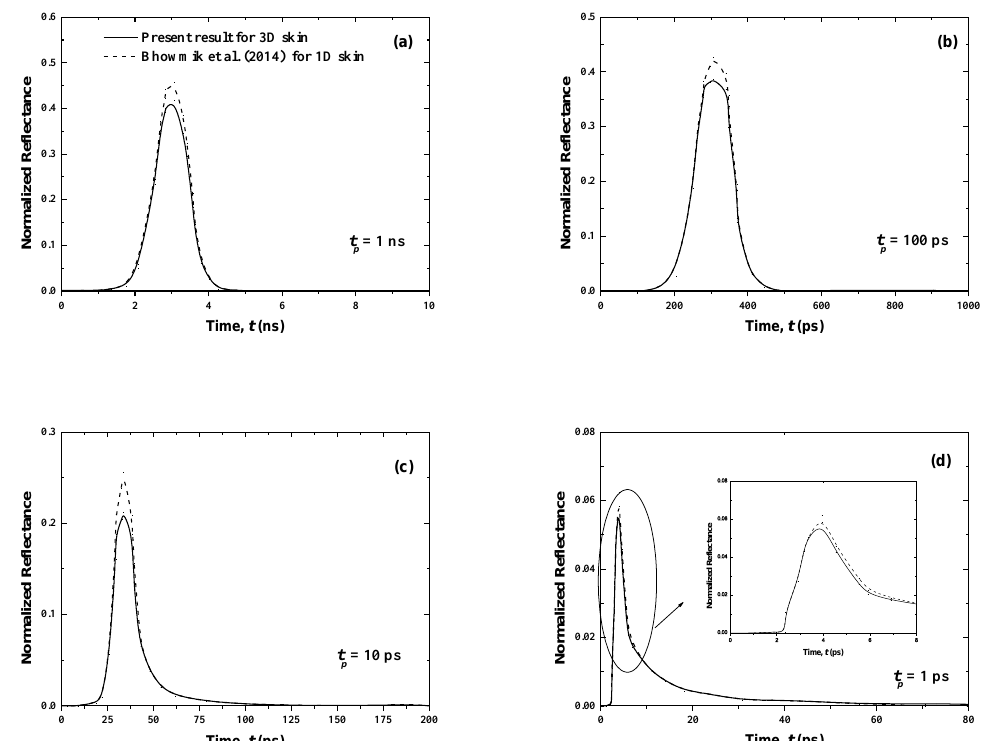
Figure 5. Temporal signals of reflectance from the normal skin subjected to the laser pulse at different pulse widths of ( a ) t p = 1 ns, ( b ) t p = 100 ps, ( c ) t p = 10 ps and, ( d ) t p = 1 ps.